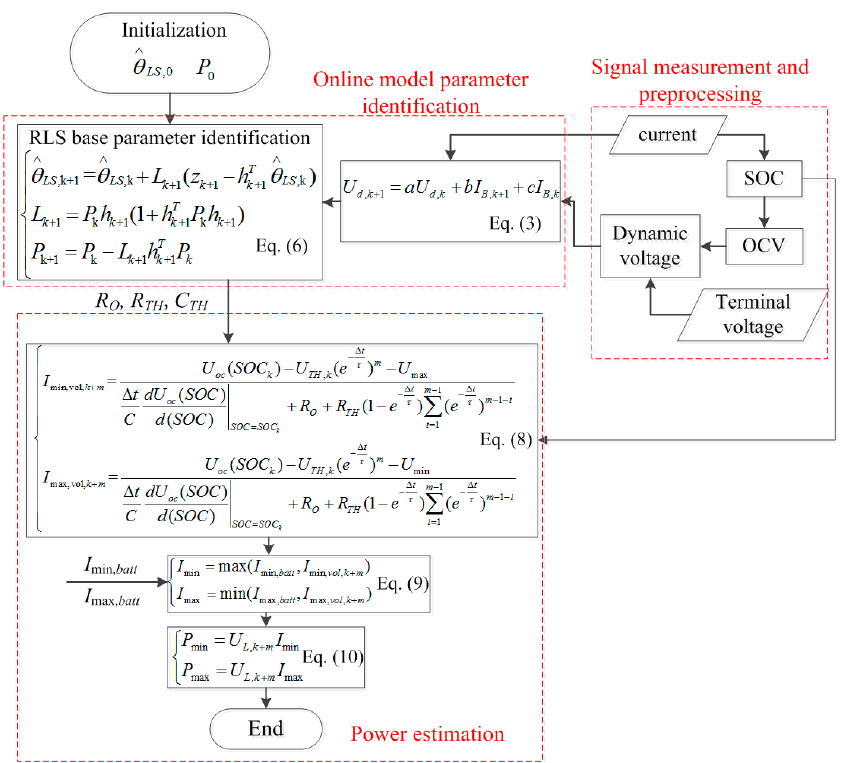
Figure 2. Peak power estimation of a single battery cell. SOC : state of charge; and OCV : open circuit voltage.